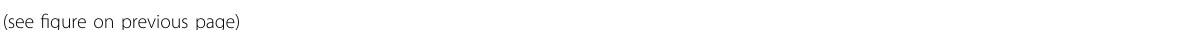
Fig. 4 Stimulus generalization. A The generalization accuracy. Percentage of correct responses across sessions to LR and LR stimuli. Rats showed a signi fi cantly higher generalization accuracy to the HR-conditioned stimulus than to the LR-conditioned stimulus in both WT and KO rats, but no signi fi cant genotype effect. B Generalization error. The percentage of incorrect responses to near-LR and near-HR stimuli. Rats made signi fi cantly fewer generalization errors in response to the near-HR generalization stimulus than the near-LR generalization stimulus but not genotype effects. C Generalization bias. Percentage of responses to interpret the ambiguous stimulus as LR or HR. Rats displayed a signi fi cantly higher generalization bias to HR in response to ambiguous stimuli, but there was no signi fi cant genotype effect. D Generalization curve. WT and KO rats had similar generalization curves. Error bars: mean with 95% con fi dence intervals. Δ PSE = KO − WT. E – J Response time (RT) during generalization. E Interaction (session and genotype) effect on RT. The response time between the genotype of KO and WT rats to each session across all stimuli. There was a signi fi cant interaction difference between genotype and session across all stimuli. F RT to LR stimulus. There was a signi fi cant genotype*session interaction for the RT assessed across three sessions. The main effect of genotype or session was not signi fi cant. G RT to HR stimulus. The RT in KO and WT rats across three sessions. There was a signi fi cant interaction effect between genotype and session. The main effect of genotype or session was not signi fi cant. H RT to near-LR stimulus. The RT between KO and WT rats across three sessions. There was no signi fi cant interaction effect between genotype and session. The main effect of genotype or session was not signi fi cant. I RT to near-HR stimulus. The RT between KO and WT rats across three sessions. There was no signi fi cant interaction effect between genotype and session. The main effect of genotype or session was not signi fi cant. J RT to ambiguous stimulus. The RT between KO and WT rats across three sessions. There was a signi fi cant interaction effect between genotype and session. The main effect of genotype or session was not signi fi cant. Note: KO ( N = 7); WT ( N = 8). The point between solid lines is the mean of the group; the dots represent individual data; the hills represent the probability distribution of the individual data; the range of the colored box represents the interquartile range; the vertical line in the colored box represents the group median; the range of colored box with whiskers on both sides represents the minimum and maximum data range; data outside the whiskers are outliers denoted by the symbol ⧫